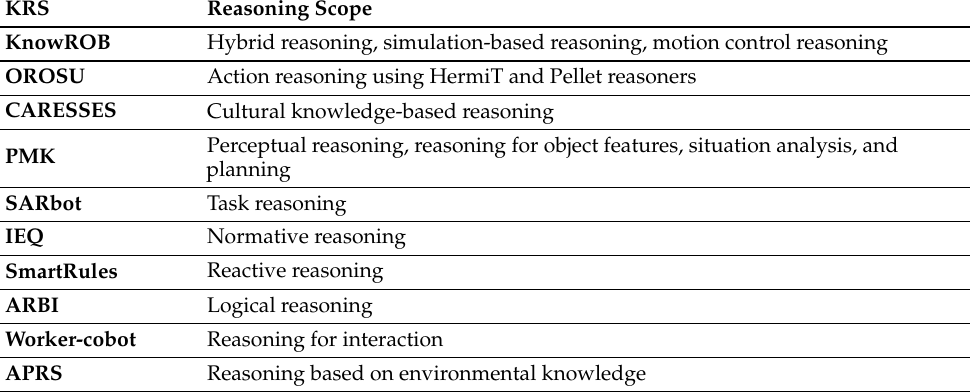
Table 9. KRSs: reasoning